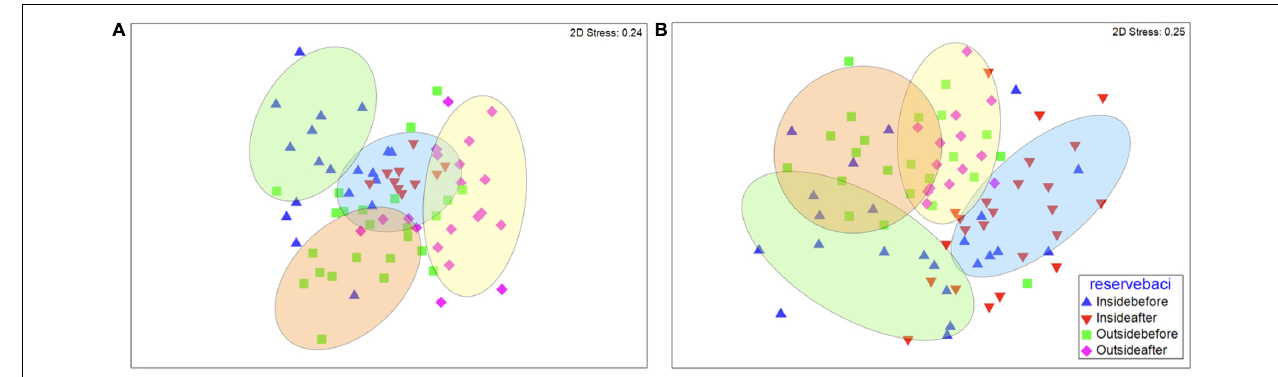
FIGURE 5 | Non-metric multidimensional scaling plot of fish species community structure similarities of (A) Cantila and (B) Cortes. Triangles denote the community structure inside marine reserve (blue indicates before and red indicates after CBM implementation), and squares and diamonds outside of marine reserves, with squares indicating before, and diamonds indicating after CBM implementation. The ellipses indicate significant clusters ( P < 0.05).